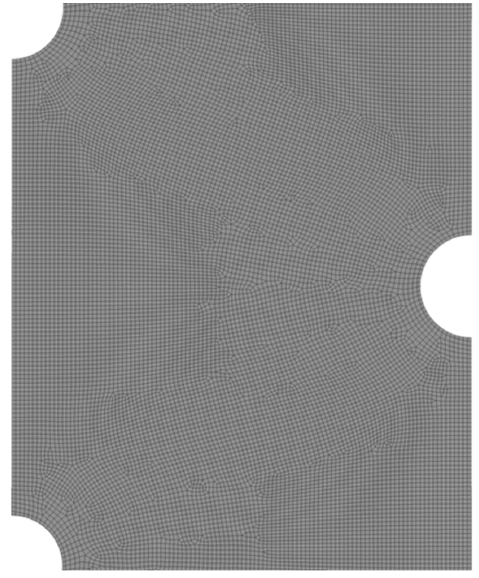
Figure 2. The mesh with 52,682 nodes in the middle of the domain.